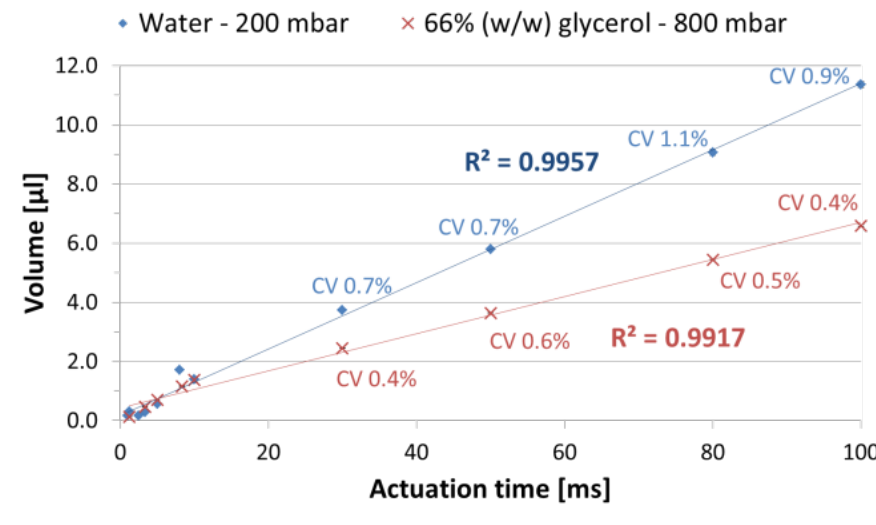
Figure 8. Detail of Figure 7 for actuation times ≤10 ms. The measured minimum volume was 163 nL for water ( Intra-Run CV 1.6%) and 123 nL for glycerol ( Intra-Run CV